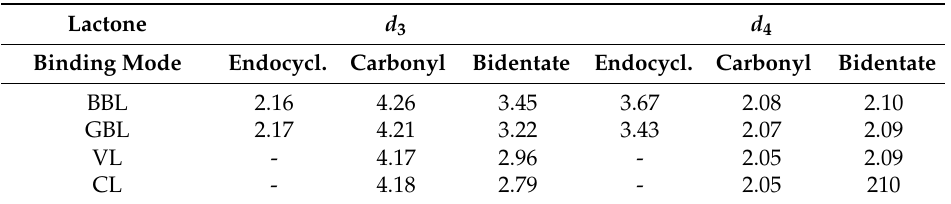
Table 5. Distances between magnesium and relevant oxygen atoms of the coordinated lactones in the